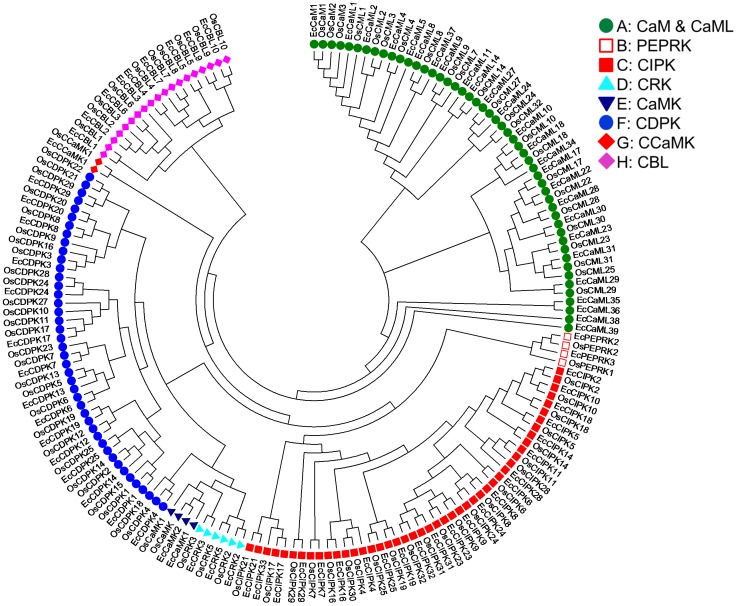
Phylogenetic tree of calcium sensor genes of rice and finger millet.Neighbor-joining tree was created using MEGA6 software with 1000 bootstrap using ORF sequences of rice and finger millet CaM and CaMLs, CBLs, CRKs, PEPRKs, CaMKs and CCaMK proteins. Eight groups were labelled as A, B, C, D, E, F, G and H.